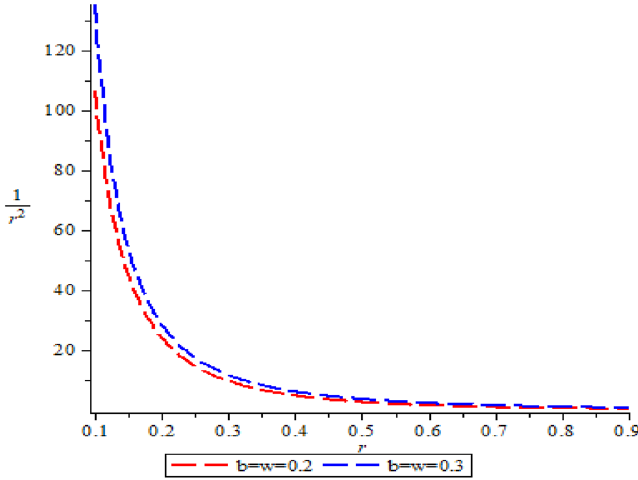
Figure 1. Standard Greene–Aldrich approximation to the centrifugal